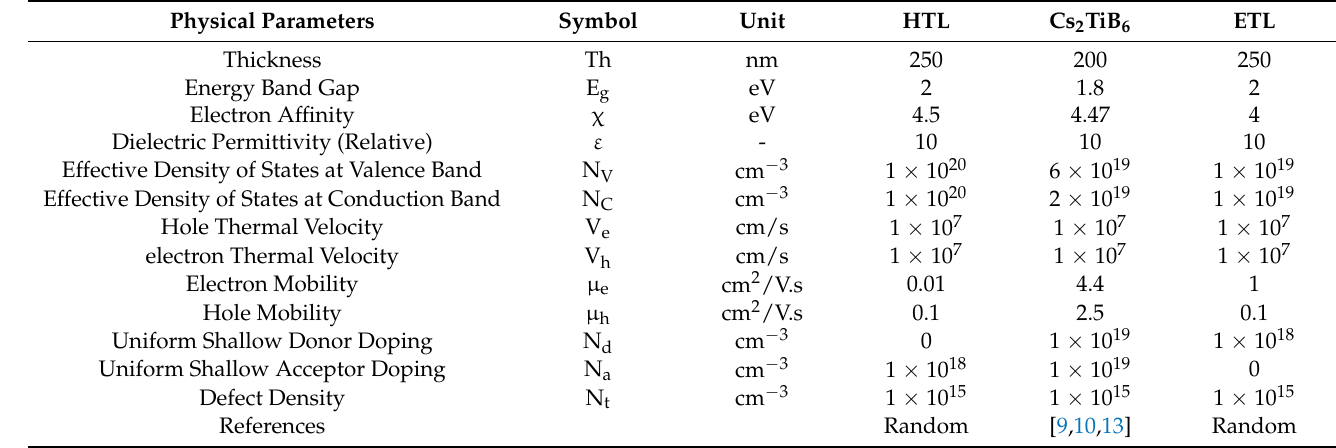
Table 4. Physical parameters of Cs 2 TiBr 6 and hole and electron transport layer used in the